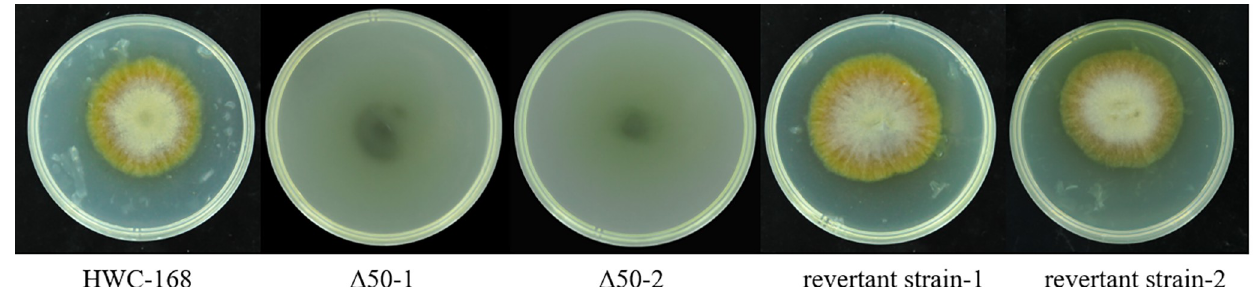
Fig 6. Penetration of the WT, Δ 50 mutant and revertant strains. The colony morphology of WT (left), Δ 50 mutant (middle) and revertant strains (right) filtered through three layers of sterile cellophane.